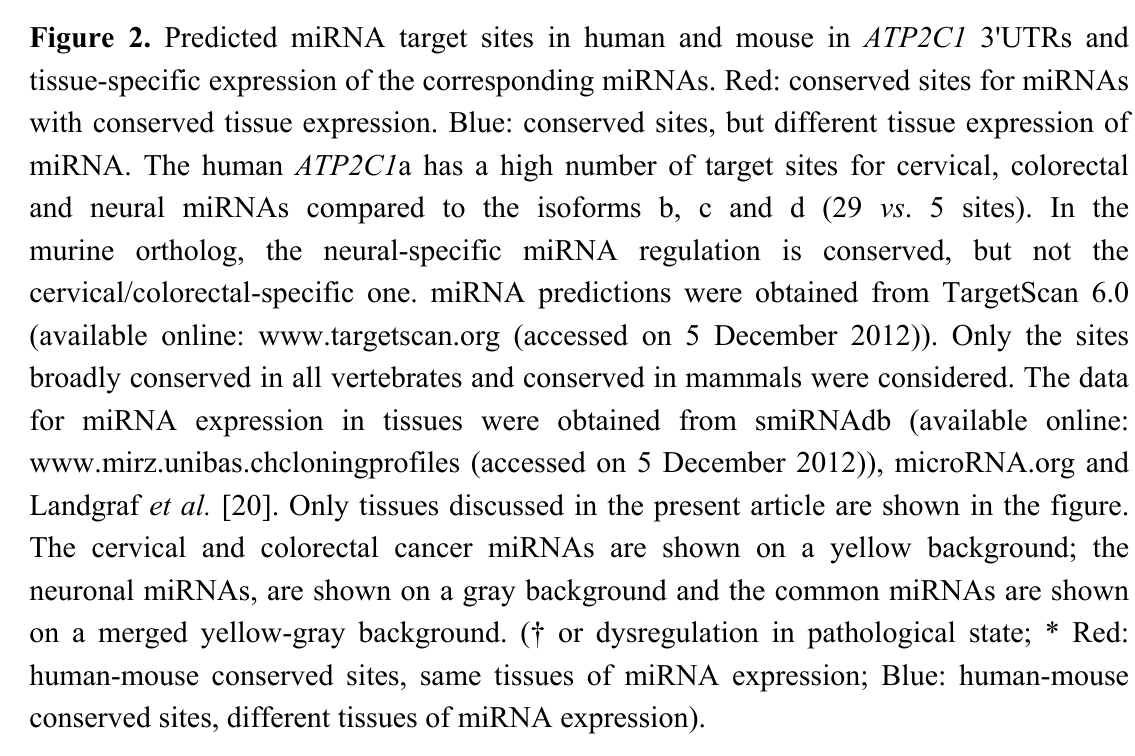
Figure 2. Predicted miRNA target sites in human and mouse in ATP2C1 3'UTRs and tissue-specific expression of the corresponding miRNAs. Red: conserved sites for miRNAs with conserved tissue expression. Blue: conserved sites, but different tissue expression of miRNA. The human ATP2C1 a has a high number of target sites for cervical, colorectal and neural miRNAs compared to the isoforms b, c and d (29 vs . 5 sites). In the murine ortholog, the neural-specific miRNA regulation is conserved, but not the cervical/colorectal-specific one. miRNA predictions were obtained from TargetScan